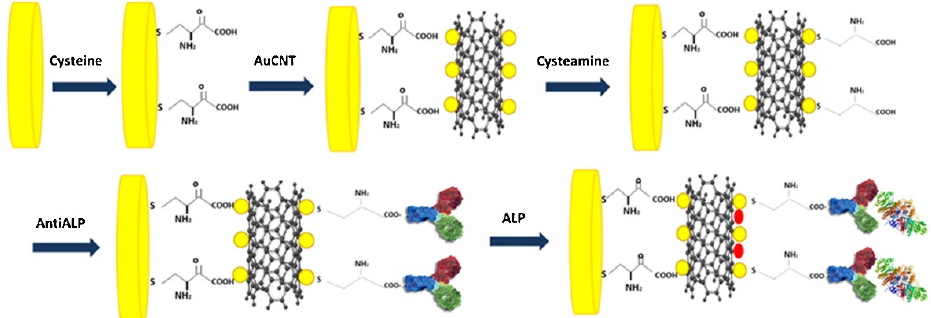
Figure 6. Example of impedimetric immunosensors with covalently immobilized antibodies. MWCNT–AuNP-based immunosensor was fabricated by the immobilization of antibodies on car- boxyl-functionalized MWCNT–AuNP using EDC/NHS chemistry. Reproduced with